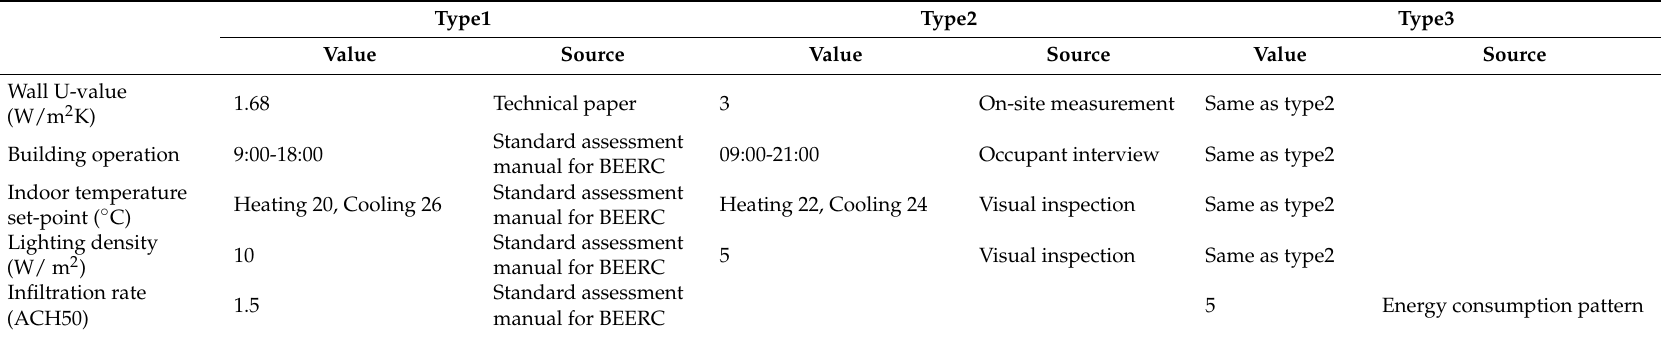
Table 9. Investigated and estimated parameters of UB2 according to the assessment